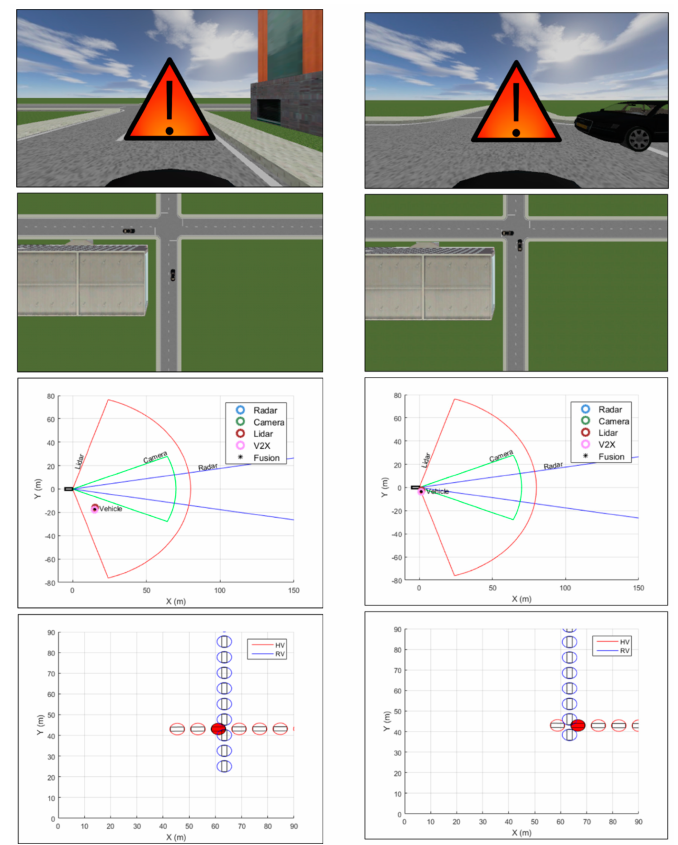
Figure 8. Vehicle–vehicle collision simulation results and snapshots of the experimental environment at two different time points (images obtained from